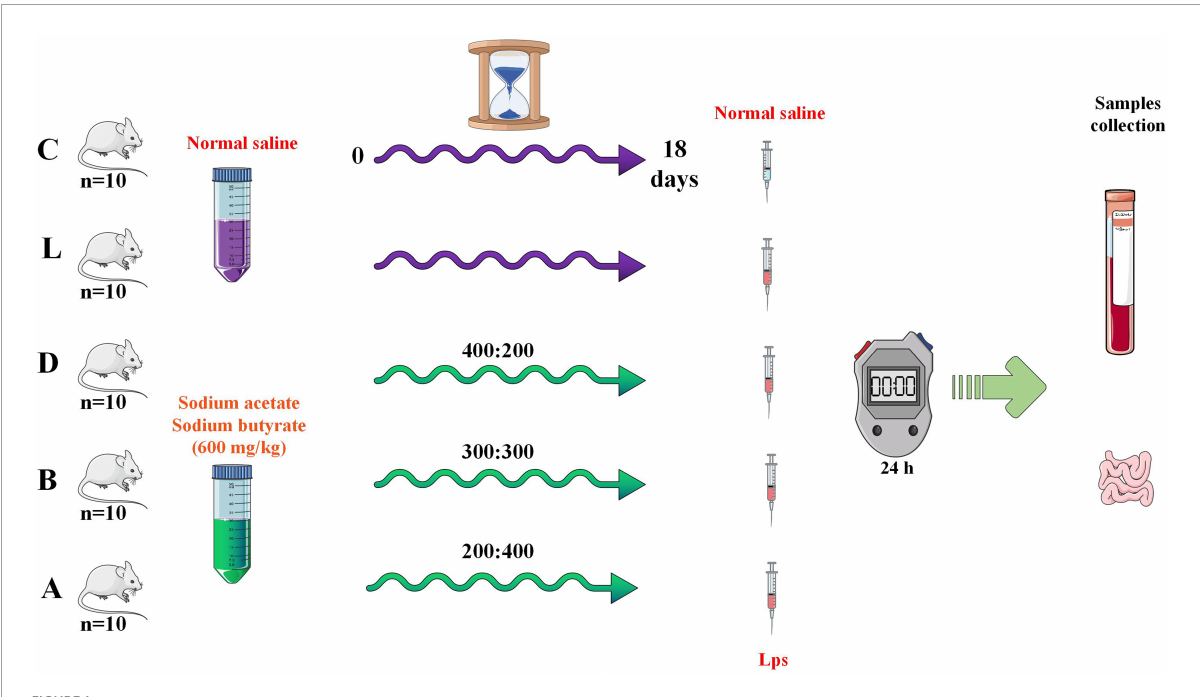
FIGURE1 Study design for the